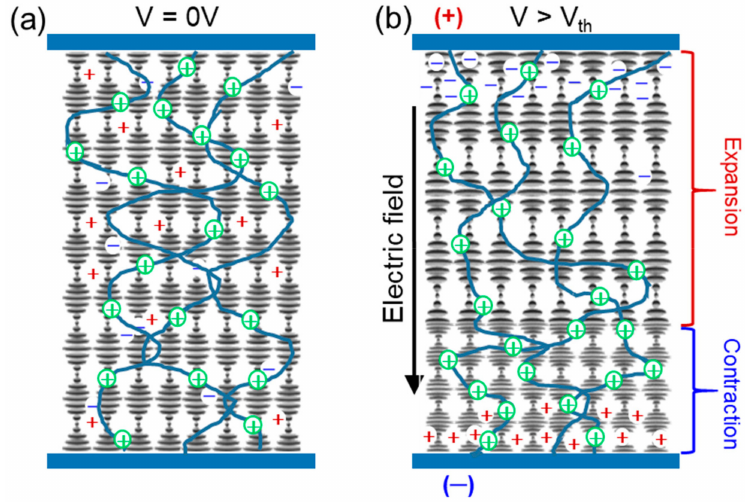
Figure 1. Schematic of the polymer network in a deformable polymer-stabilized cholesteric liquid crystal (PSCLC) with ∆ ε < 0: ( a ) with no applied field, ( b ) with a DC field applied between the top and bottom substrates. The blue lines represent the polymer network, the grey horizontal bars are the low-molecular-weight cholesteric liquid crystal (CLC) molecules, + and – are the free cationic and anionic impurities and ⊕ are trapped cationic